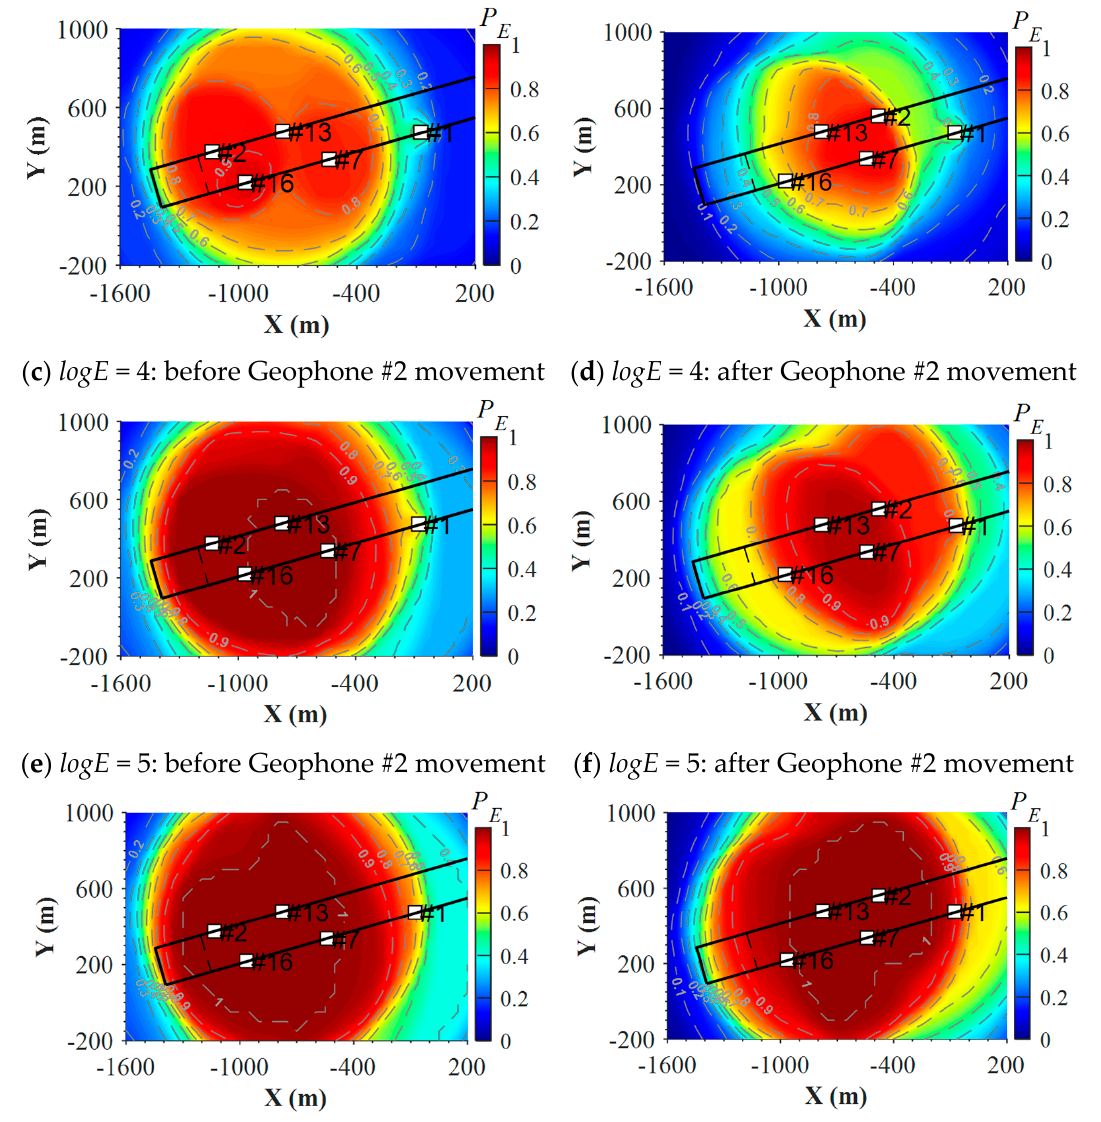
Figure 9. Distribution of detection probability of seismic events with different energies one week before ( left figures) and after ( right figures) Geophone #2 had been moved on 5 July 2014 in LW250105. Dashed lines show the position of the longwall face, and white square indicates a geophone.